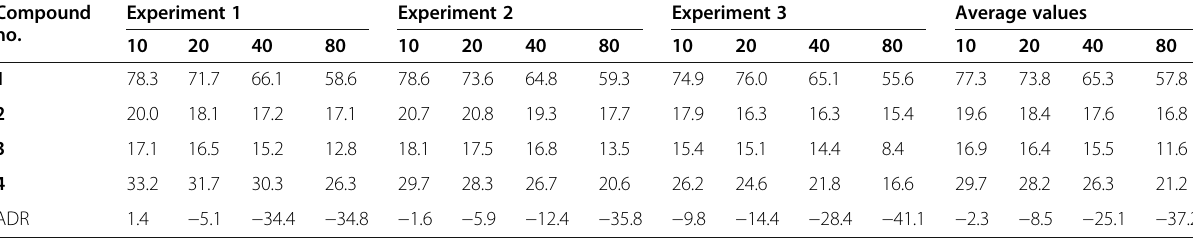
Table 3 % Control growth the drug concentrations ( μ g/mL) HOP62 cell line Compound